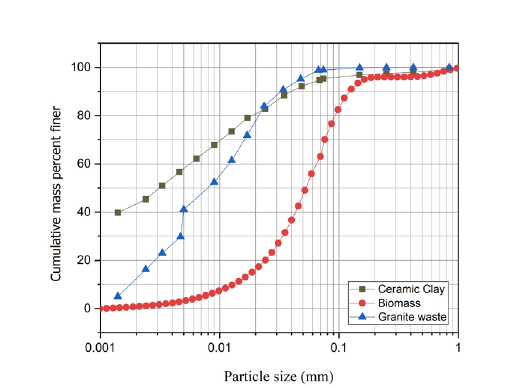
Figure 2. Particle size distribution of raw